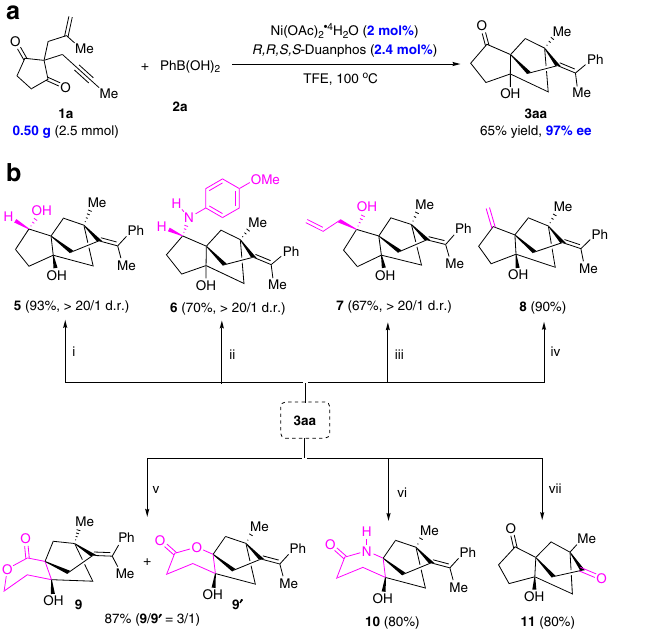
Fig. 5 Half-gram scale reaction and synthetic manipulations. a Half-gram scale reaction. b Synthetic applications. (i) NaBH 4 , EtOH, 0 °C~ rt; (ii) 4-methoxyaniline (3 equiv), NaBH 3 CN, MeOH, rt; (iii) allylMgBr, THF, − 78 °C-rt; (iv) PPh 3 MeBr, t BuOK, THF, 0 °C-rt; (v) m -CPBA, NaHCO 3 , DCM, rt; (vi) NaN 3 , TFA/H 2 O = 4/1, 70 °C; (vii) O 3 /PPh 3 , DCM, − 78 °C-rt. m -